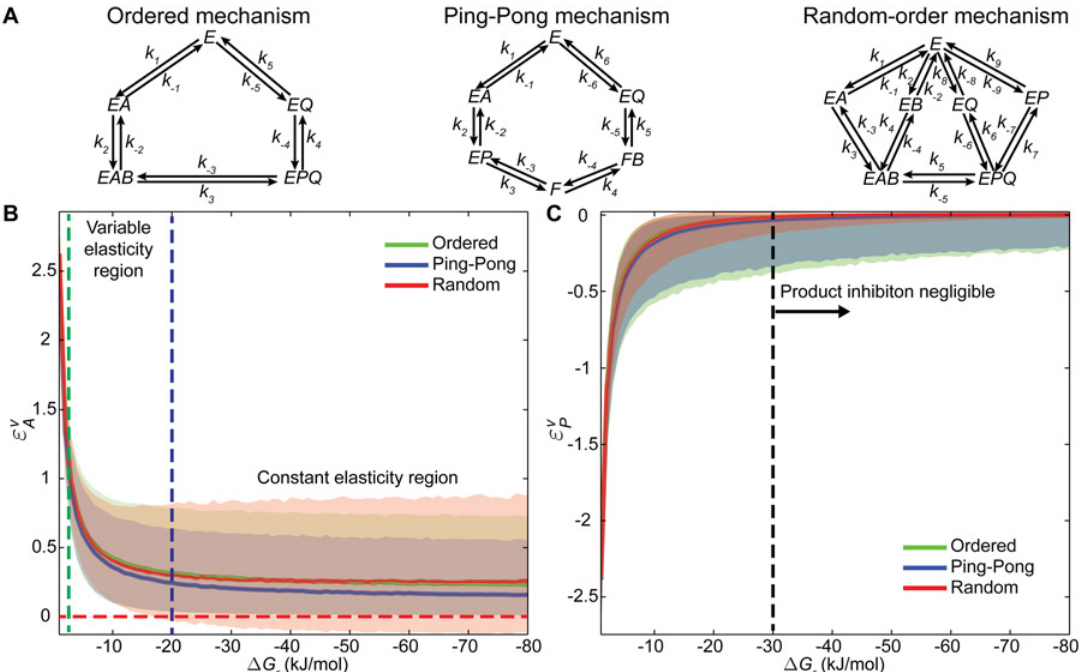
Fig 3. Revealing the impact of thermodynamics on enzyme kinetics. (A) Schematic representation of the bimolecular mechanisms considered for the analysis. (B) Substrate elasticities for three mechanisms considered: ordered (green), ping-pong (blue) and random-order (red) at different Gibbs free energy differences of reaction ranging from -1 to -80 kJ/mol. Elasticities were calculated every -1 kJ/mol interval by sampling 10 4 instances each time. In this panel, each line represents the median of the respective elasticity distribution, while the shaded areas denote the 95% confidence regions. Depending on the chosen thermodynamic reference state, the elasticities can be almost constant for regions far from equilibrium ( Δ G r < -20 kJ/mol) or highly variable close to equilibrium (dashed blue line). The dashed green line represents the limit for the lineal regime of substrate elasticity variation, while the dashed red line denotes the zero limit. (C) Product elasticities for the same representative bimolecular mechanisms. The lines and shaded areas represent the same as for the substrate elasticities. Product inhibition is on average negligible for favourable thermodynamic conditions, i . e . Δ G r < -30 kJ/mol (right side of the dashed blue